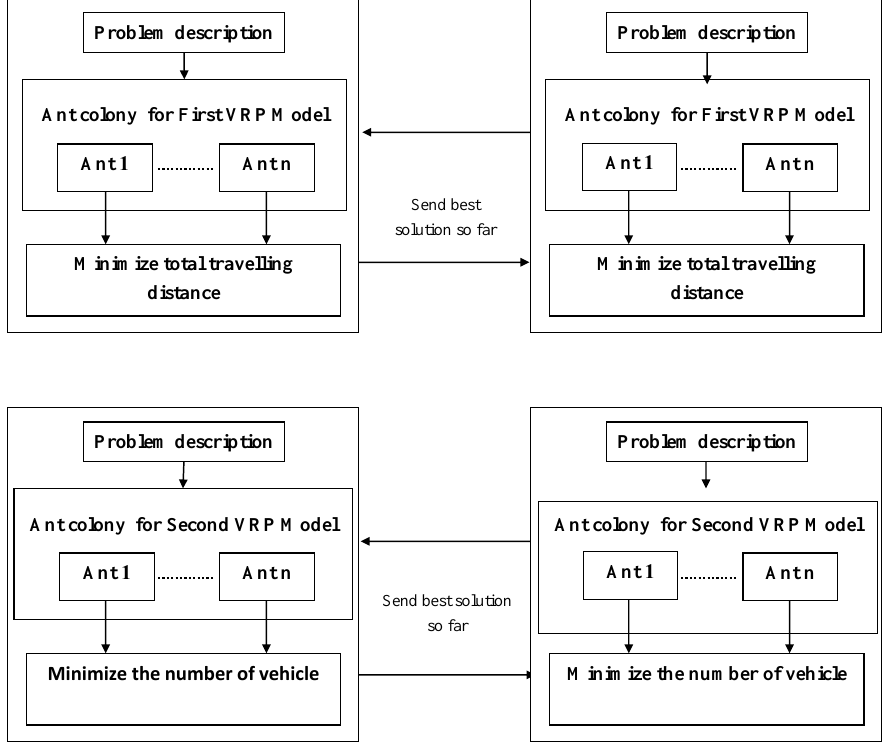
Figure 5. Graph of VRP interaction